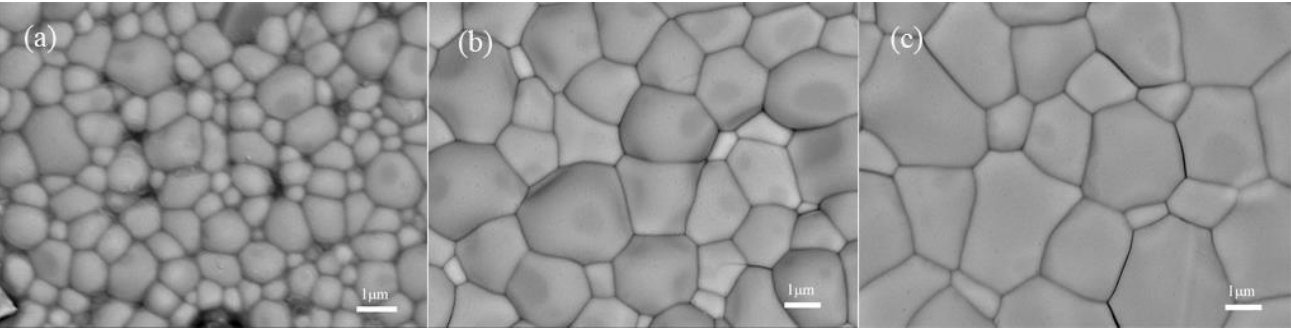
Figure 2. SEM images (shown in BSE) for the surface of ( a ) LCNO, ( b ) 1 wt.% NiO externally doped LCNO and ( c ) 1 wt.% NiO internally doped LCNO .